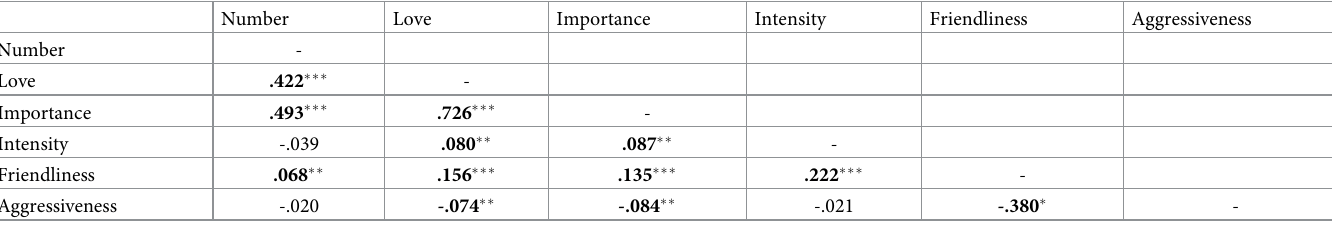
Table 1. Matrix of Pearson correlations with the means of the five